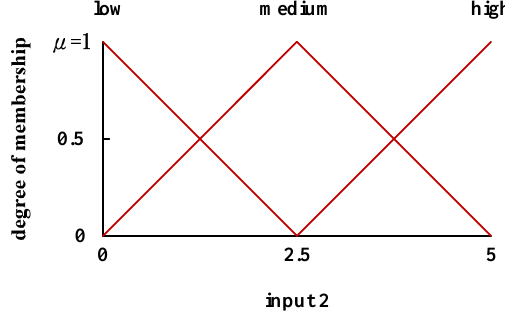
Figure 3. Degree of membership of the cutting depth.